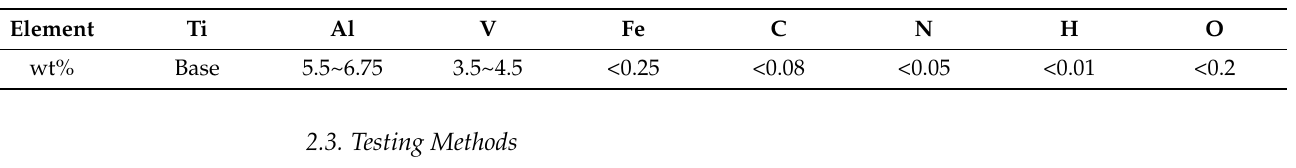
Table 2. Chemical element quality composition of the workpiece material Ti6Al4V